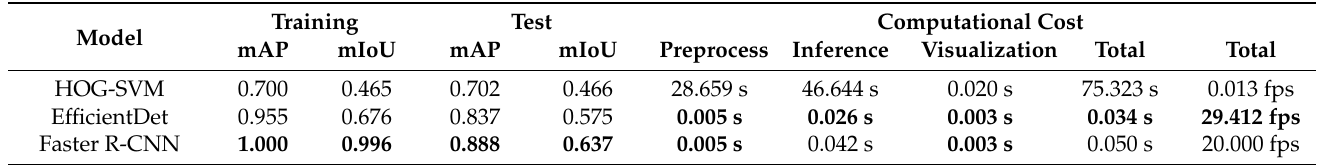
Table 6. Comparison of model performance and computational cost (Best performance marked in